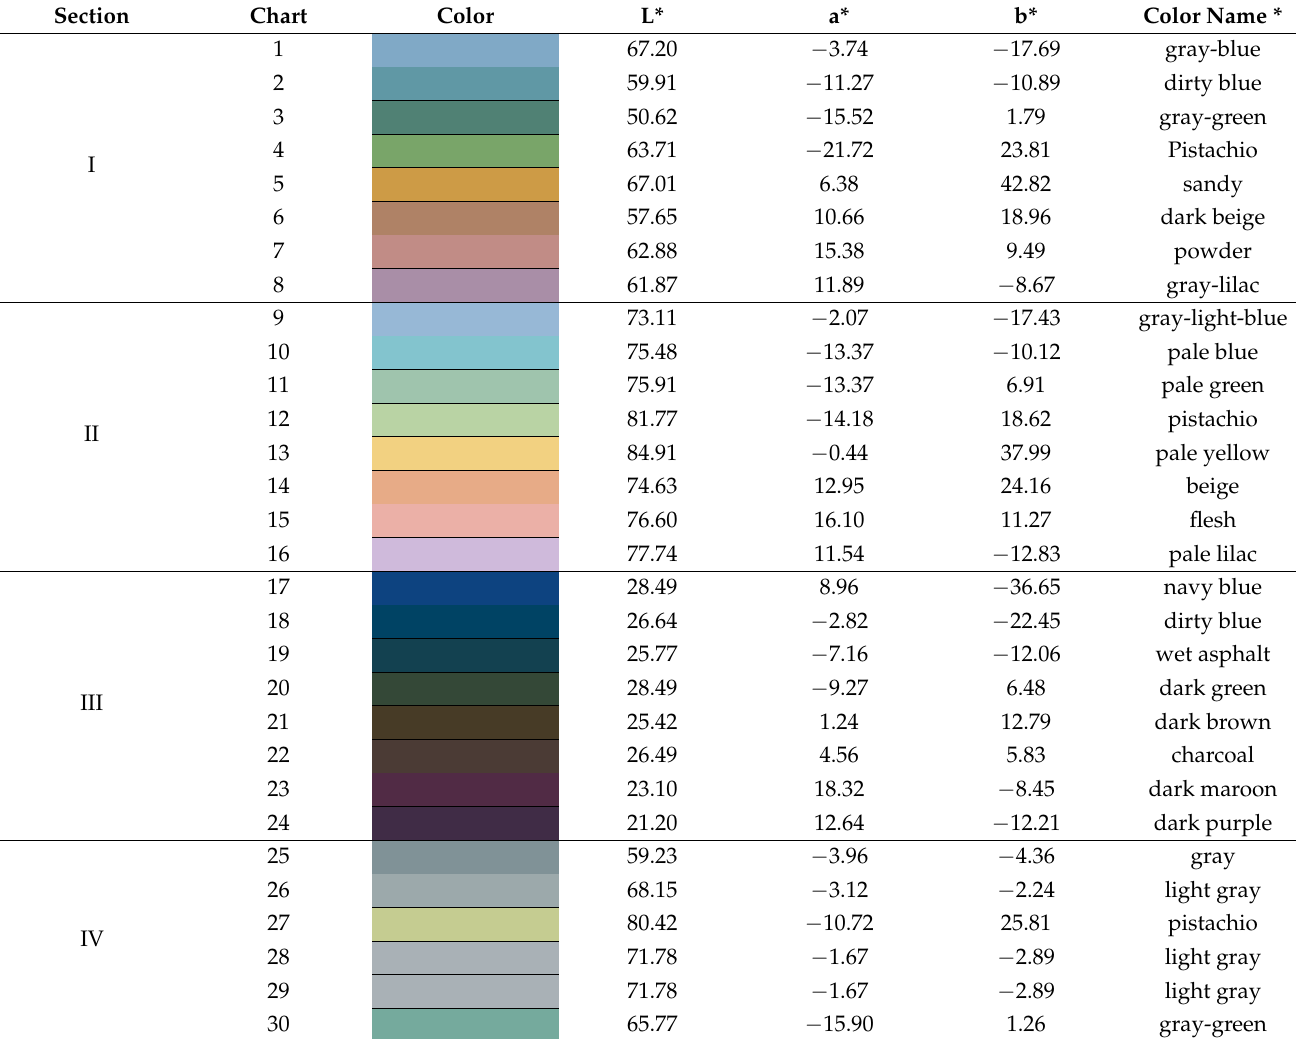
Table 2. Environmental background